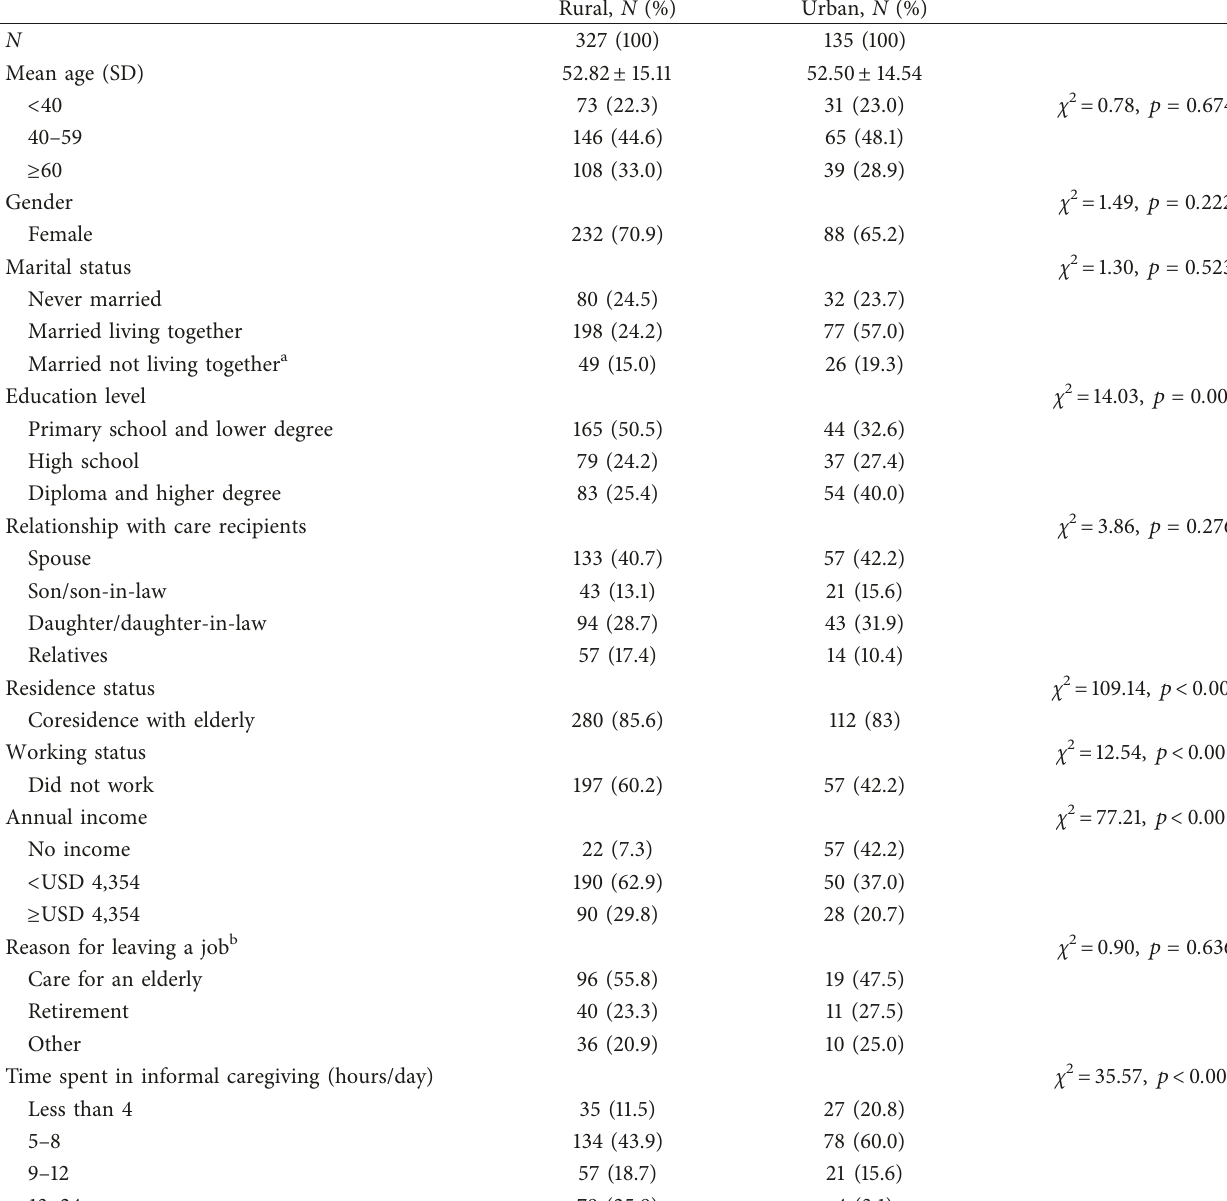
Table 4: Characteristics of caregivers ( N �